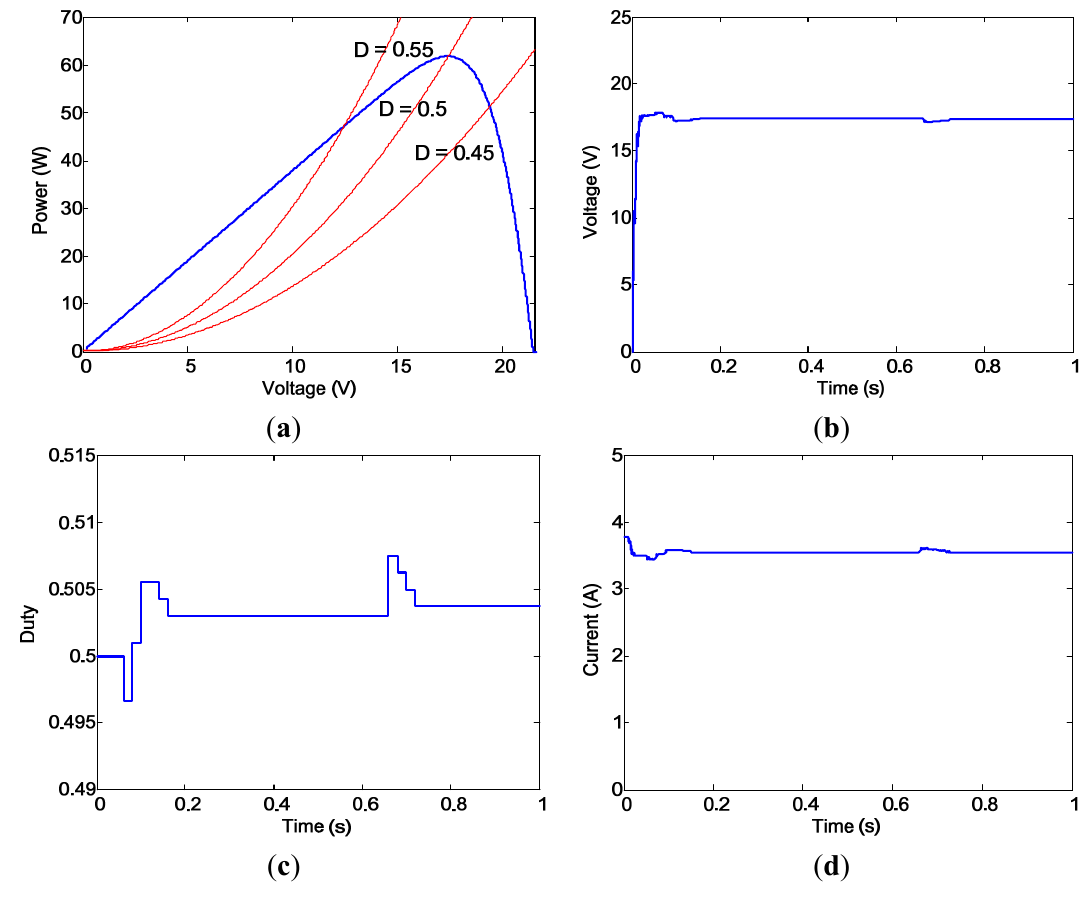
Figure 15. Circuit simulation results with 4.9  load. ( a ) Power characteristics; ( b ) Duty ratio command; ( c ) Output voltage from PV model; ( d ) Output current from PV